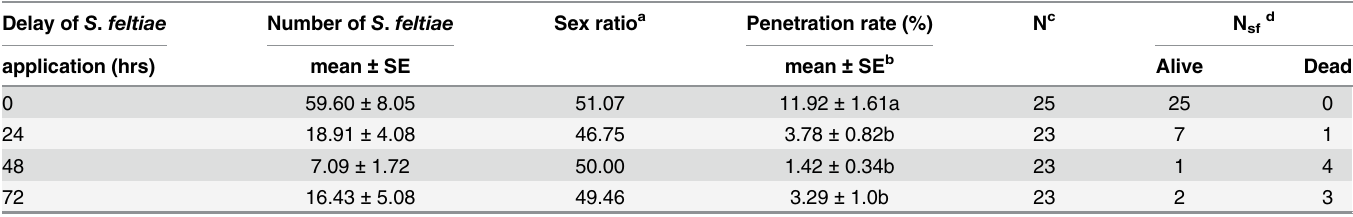
Table 6. Mean number of S . feltiae found in cadavers of L . decemlineata last-instar larvae inoculated with 500 IJs per dish in different times after the fungus application, calculated penetration rates and number of cadavers with either alive or dead nematodes. Delay of S .